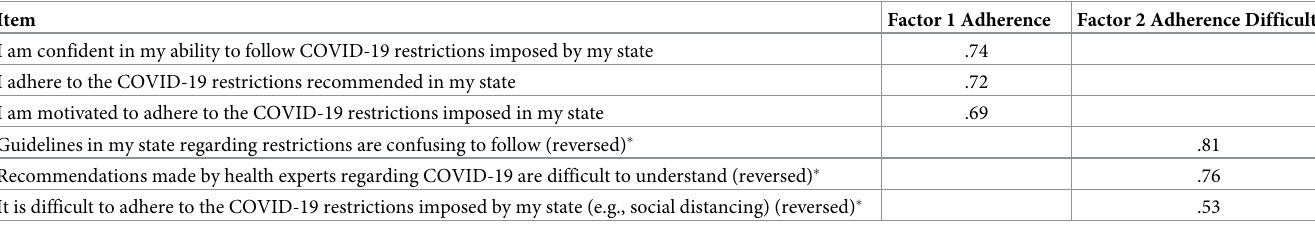
Table 7. Item loadings for a forced two-factor model for adherence to COVID-19 restrictions using Principal Axis